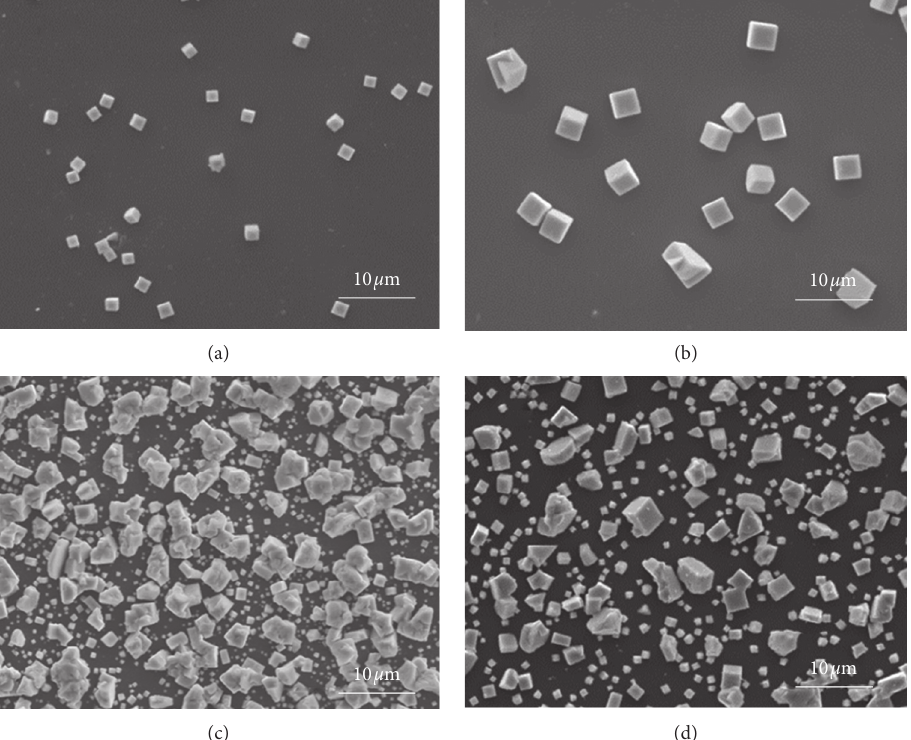
Figure 4: SEM images at 5000x magnification of thin films deposited from [Pb((SeP i Pr and (d) 450 ° C.